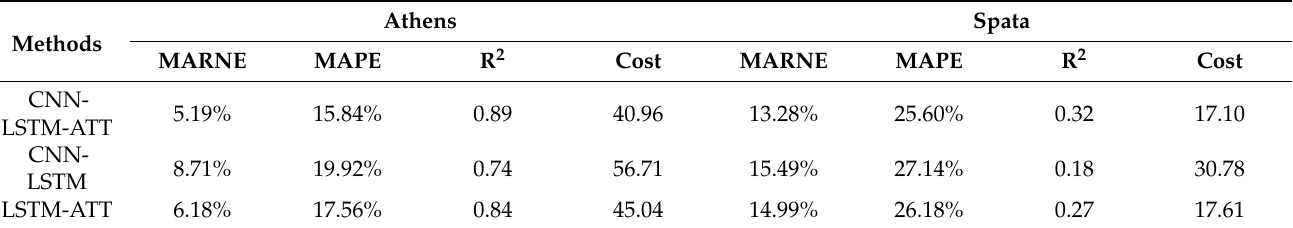
Figure 6. The forecasting curves and errors of two enhanced methods for LSTM. Table 3. Forecasting results of the three enhanced methods for